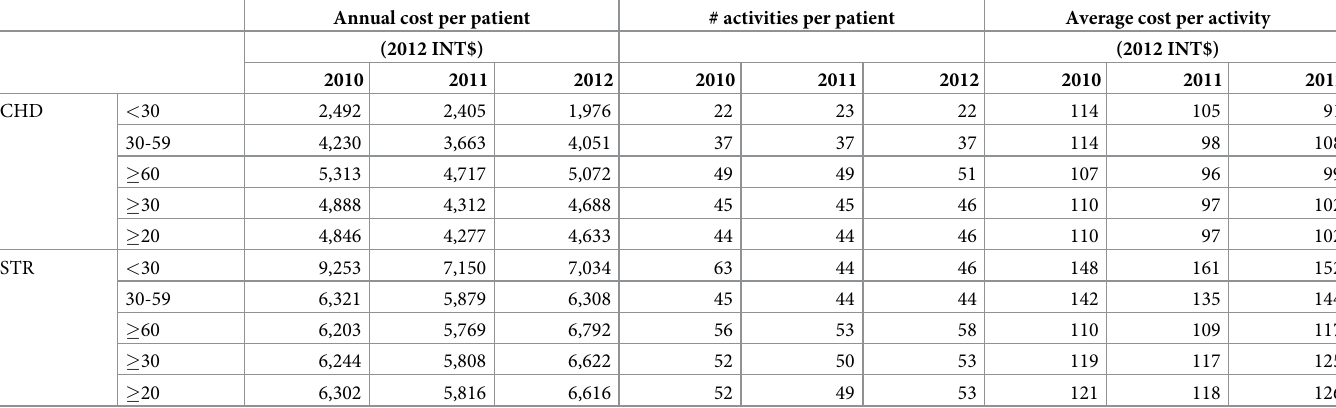
Table 4. Average healthcare cost of CVD (person-based cost of